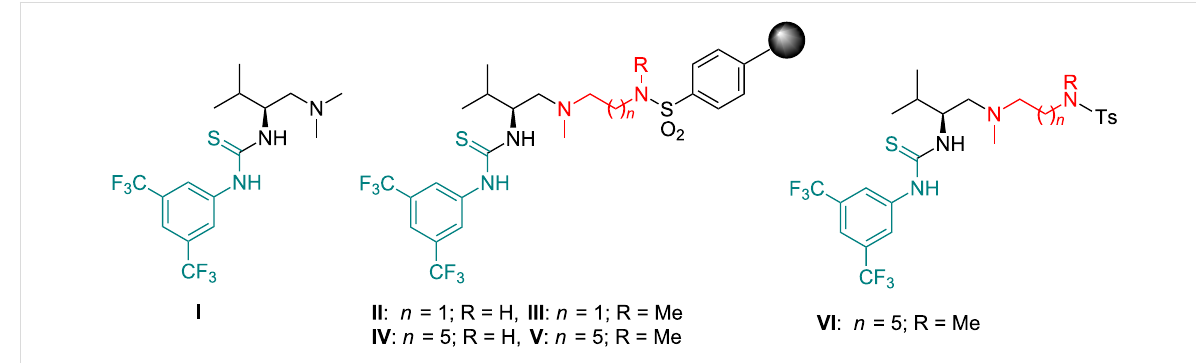
Figure 1: Parent and supported bifunctional thioureas used in this work.